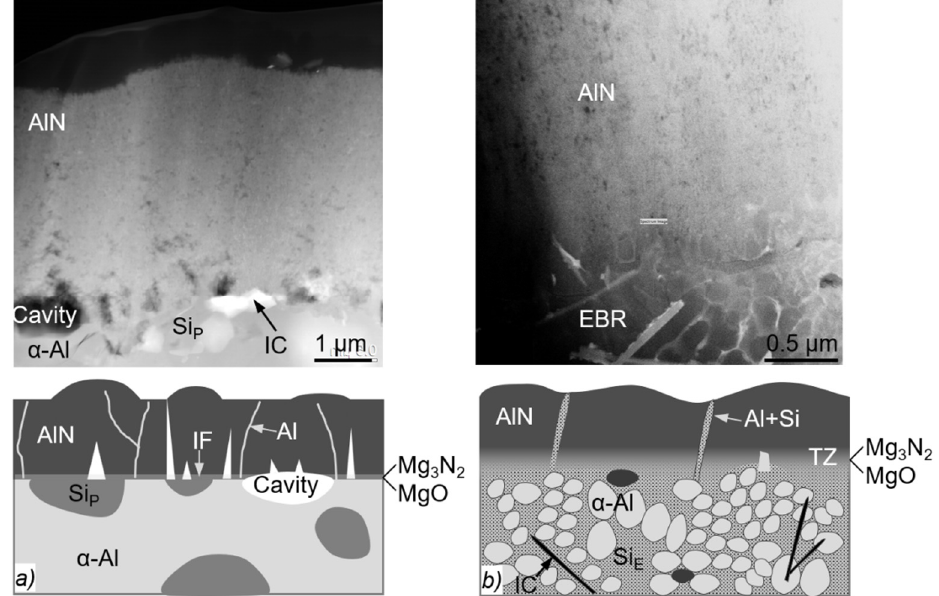
Figure 10. TEM images and schematic illustration of the interface (IF) or transition zone (TZ) between the AlN layer and ( a ) the Al substrate in the initial state after plasma nitriding, and ( b ) the remelted microstructure after subsequent EBR ( α -Al—Al solid solution; Si P —primary silicon; Si E —eutectic silicon; IC—intermetallic compound).